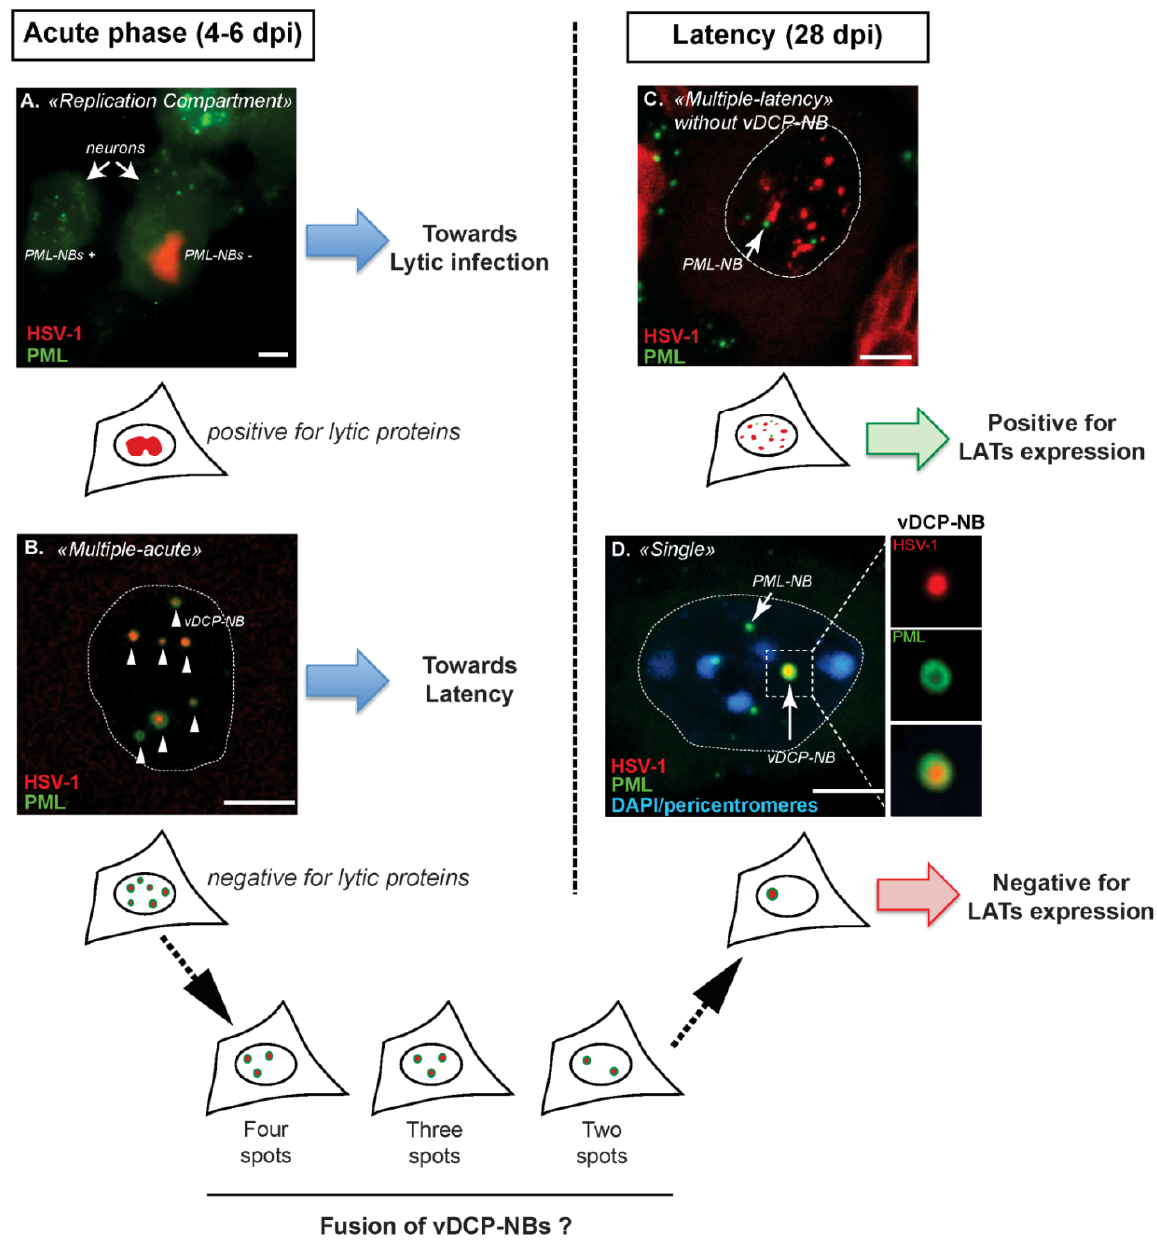
FIGURE 1: Major patterns of herpes simplex virus (HSV-1) genome distribution in infected trigeminal ganglion (TG) neurons during acute infection (4-6 dpi) and latency (28 dpi) in mice. HSV-1 genomes (red) are detected by fluorescence in situ hybridization (FISH) together with the detection of the PML protein (green) by immunofluorescence. During acute infection virus genomes adopt two main patterns: replica- tion compartments (RC) or multiple-acute (MA). (a) RC are visualized by the detection of a “cloud” of viral genomes spread within the nu- cleoplasm. In RC-containing neurons, PML-NBs are no longer detected (compare infected right neuron with uninfected left neuron) and expression of lytic proteins could be detected. (b) MA is characterized by the detection of discrete spots of viral genomes surrounded by the PML protein. These structures were defined as “viral DNA-containing PML-NBs” (vDCP-NBs). No lytic proteins were detected in MA- containing neurons. During latency (from 28 dpi onwards), two other viral genome patterns are detectable: multiple-latency (ML) or single (S). (c) ML is distinguishable from MA based on at least three criteria: (i) the viral genome spots are usually smaller; (ii) the viral genome spots detected in the nucleus are more numerous; and (iii) most of the time ML-containing neuron do not contain any vDCP-NB. (d) S corre- sponds to the detection of only one spot of viral genome in the infected neuron, forming a unique vDCP-NB. The S pattern could result from the fusion of the multiple vDCP-NBs observed in MA-containing neurons during the period of latency establishment (between 6 and 28 dpi), since in vivo , intermediate patterns of 4-3-2 vDCP-NBs-containing neurons were observed around 11 to 14 dpi. Cartoons are present below each image for a general representation of the pattern. Blue colour in (d) represents DAPI staining. Dpi, days post infection. Bars represent 10 µm. Figure 1D was partly reproduced from a previous article by the author (Lomonte P. Virologie 2014; 18(3): 170-9. doi:10.1684/vir.2014.0569) who have obtained the agreement of the publisher to use it in the present